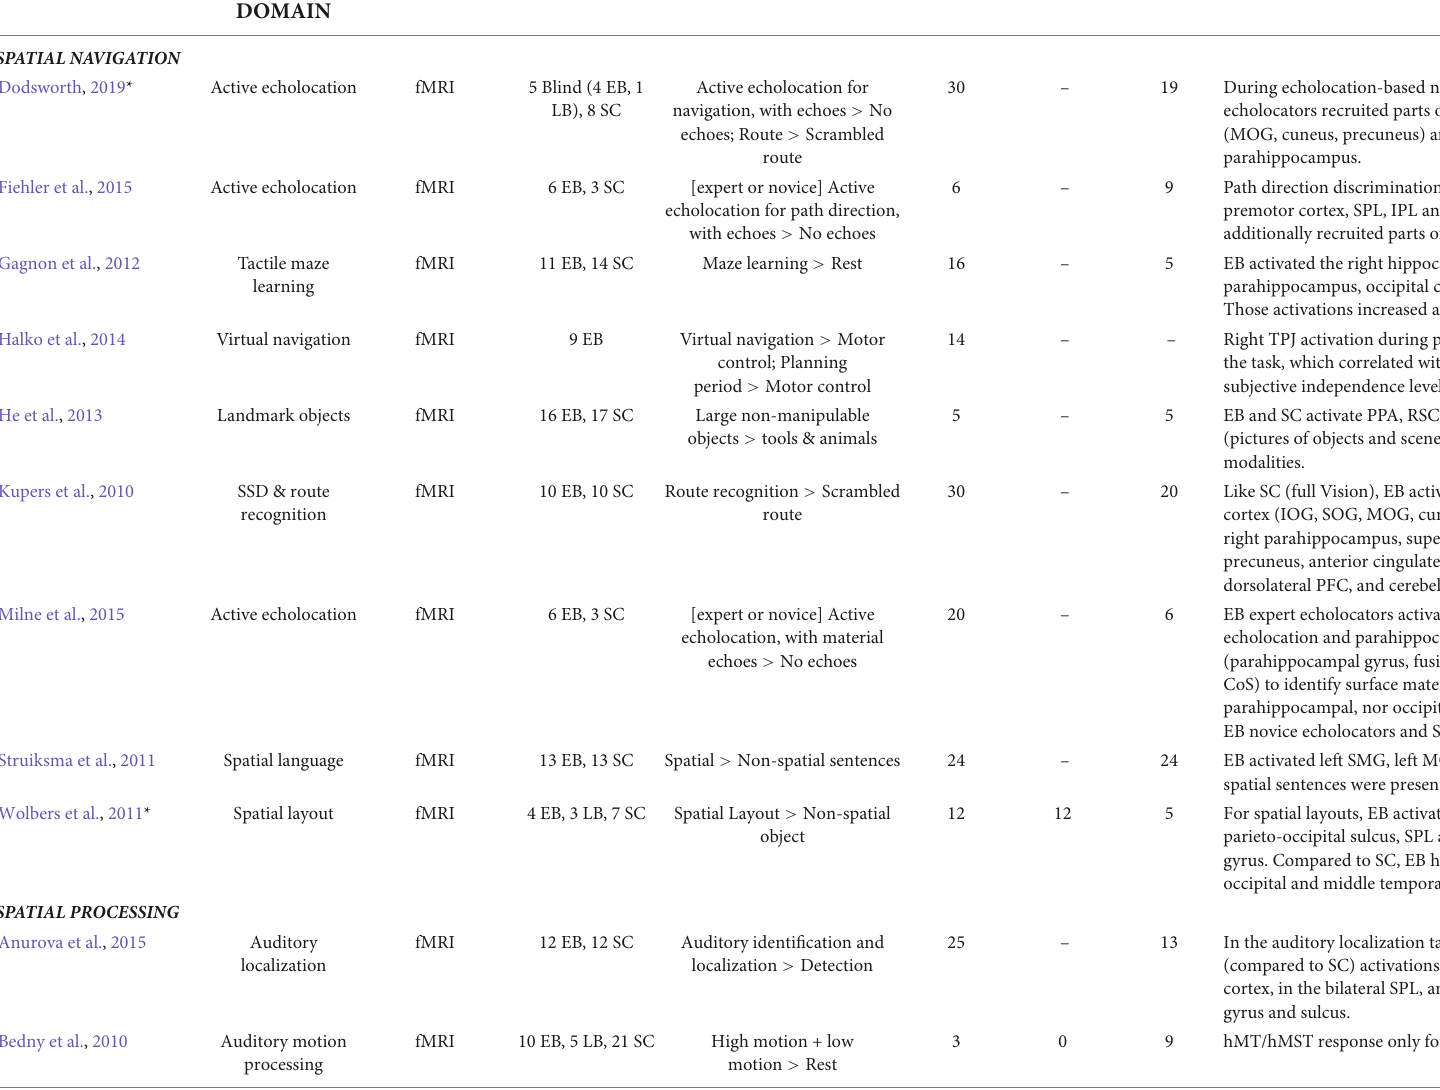
TABLE 2 Overview of included